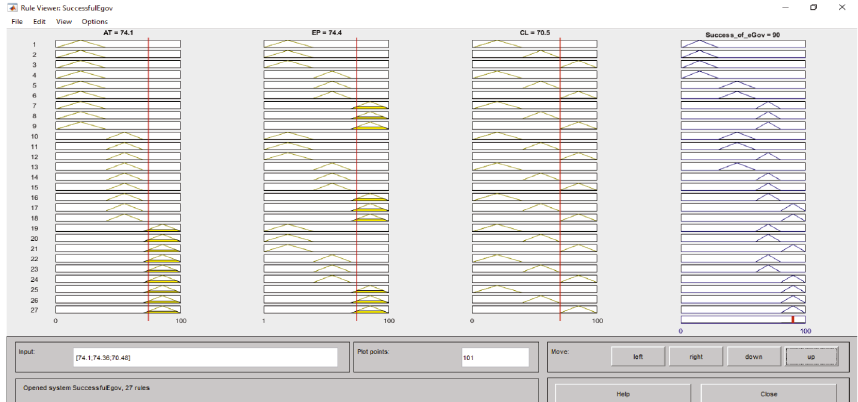
Figure 7: Rule base and output assessment values.